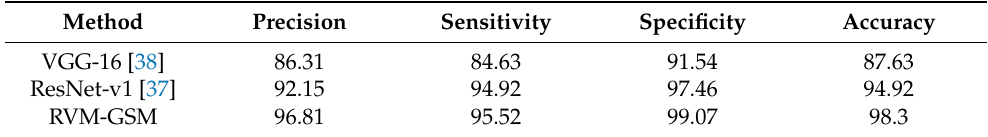
Table 3. Comparison results of models on the Srinivasan 2014 dataset.